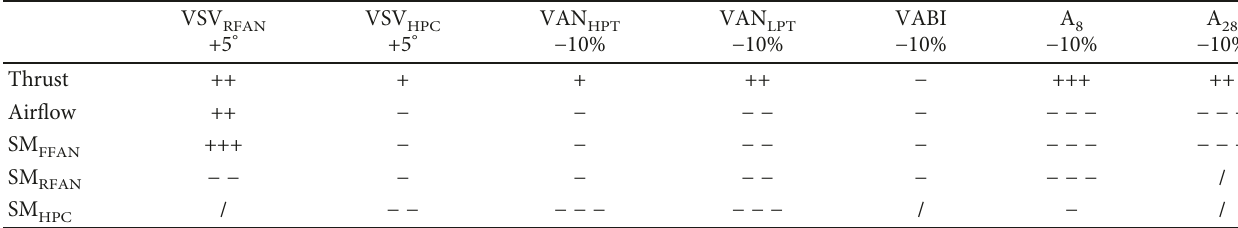
Table 3: Result of variable geometries ’ sensitivity